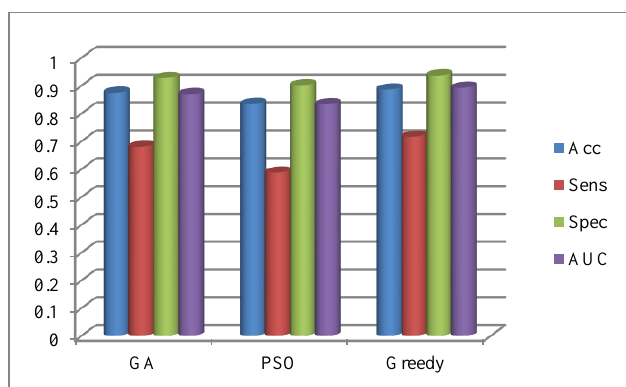
Figure 3. Feature selection method performance (average of 24 model performance for each feature selection